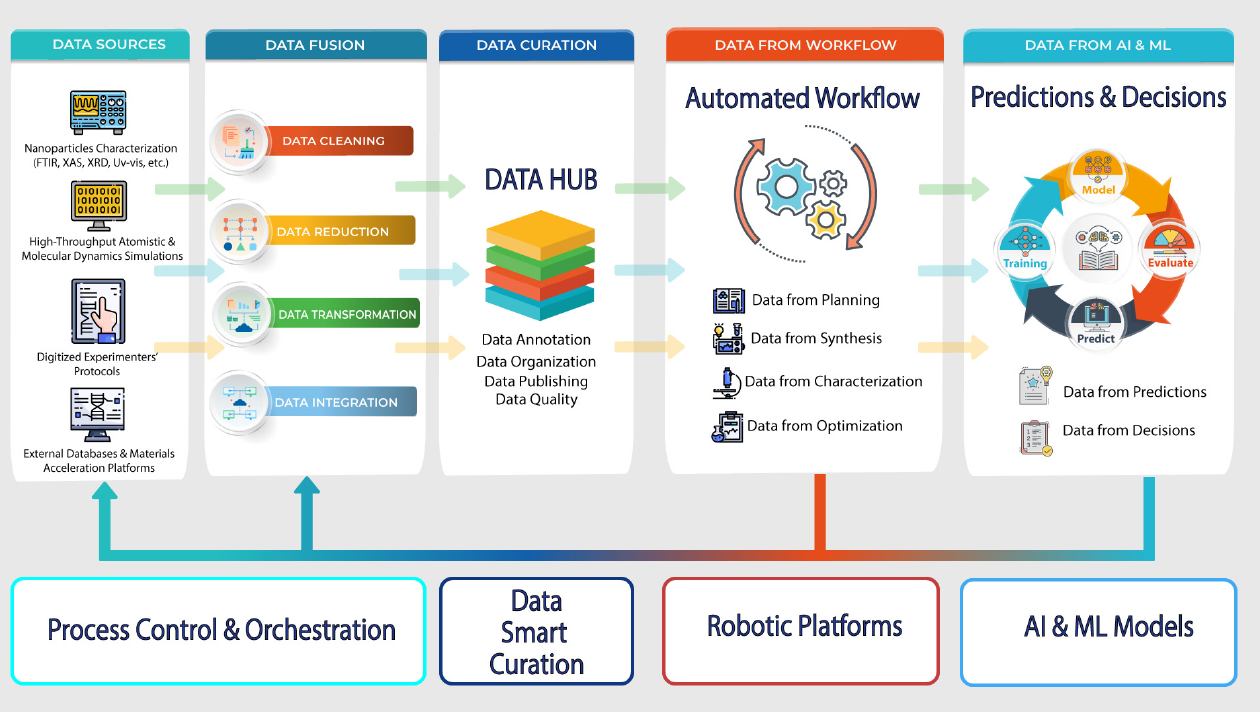
Figure 3. Data-centric architecture for SDL.